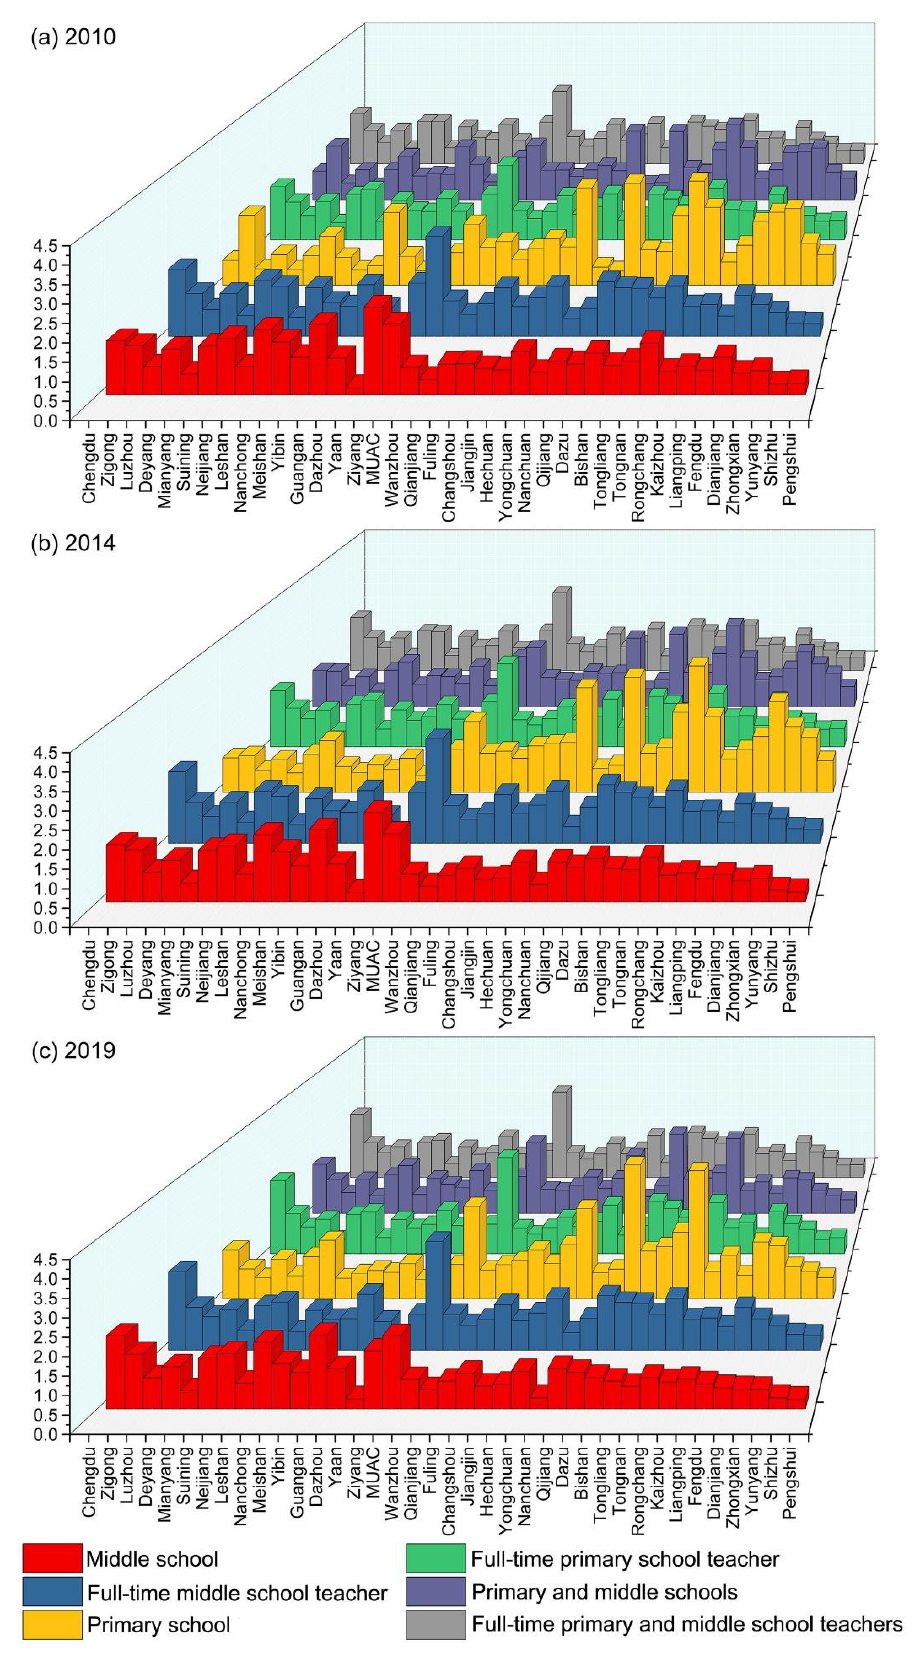
Figure 8. ERAD in ( a ) 2010; ( b ) 2014; and ( c ) 2019. To evaluate the fairness of the distribution of educational resources, we used the DEP as a measurement standard (Figure 9). To facilitate analysis, we divided the changes in